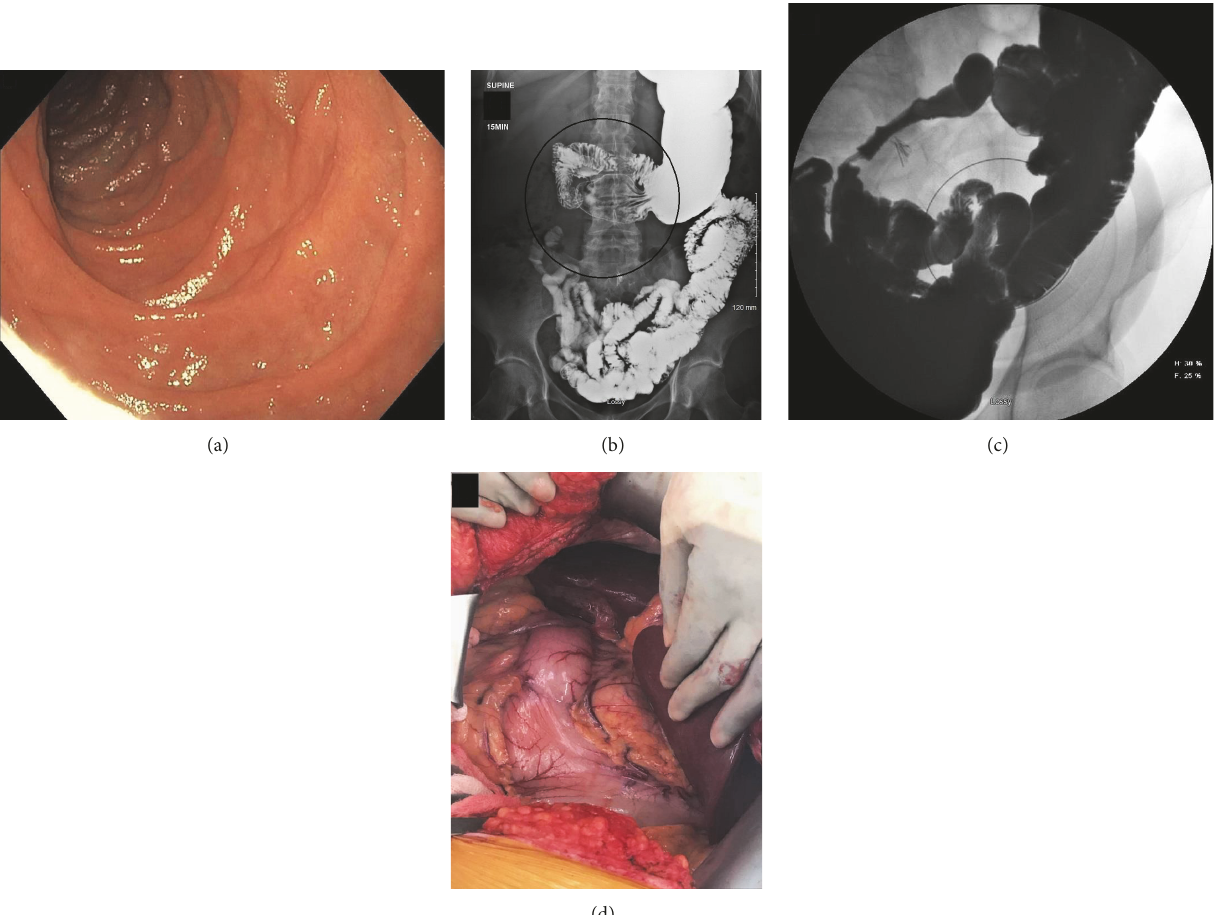
Figure 1: (a) Endoscopic image, normal duodenum. (b)-(c) Upper gastrointestinal series with small bowel following through with barium contrast. (d) Exploratory